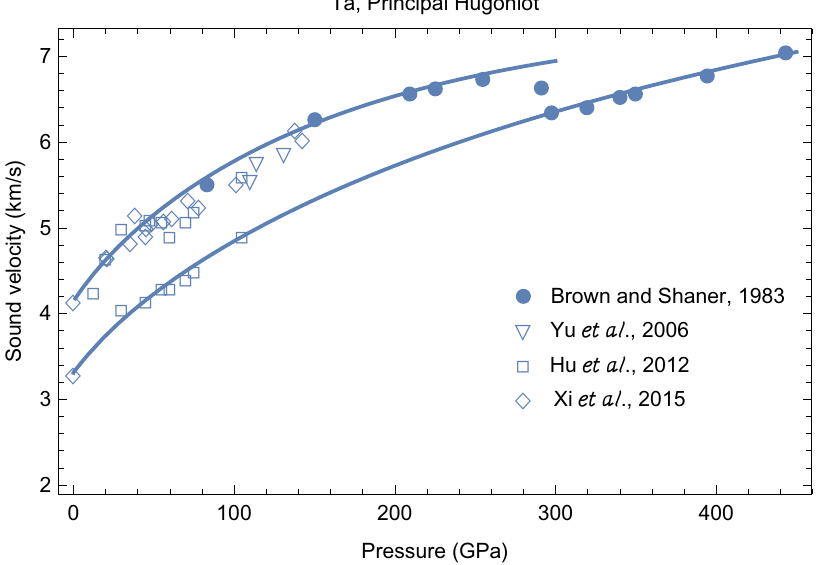
Figure A2. Longitudinal (upper) and bulk (lower) sound velocities in bcc-Ta along its principal Hugoniot: comparison of the unified analytic melt-shear model (curves) to the experimental data of References